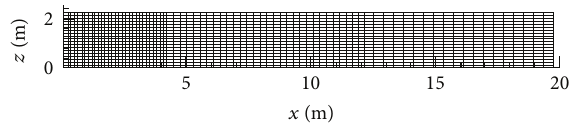
Figure 2: Grids for radiance calculation in the plume.